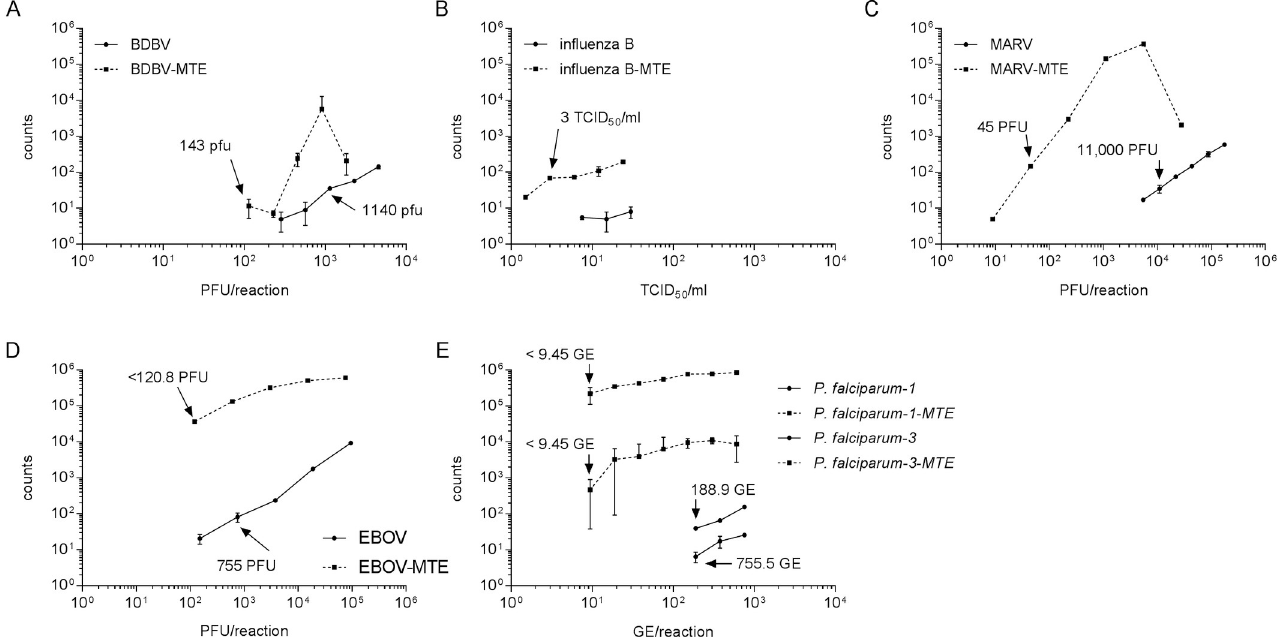
Fig 1. Improved PCR detection following MTE. BDBV (A), influenza B strain 38 (B), MARV (C), EBOV (D), and P . falciparum (E) nucleic acid were serially diluted. One dilution series was amplified by MTE prior to being run in the SYBR Green assay. The amount of pathogen-specific nucleic acid was determined by real-time PCR using primers internal to the MTE amplification primers. Fig B is shown as a dilution factor because influenza B strain 38 did not titer. Samples were run in triplicate, and the error bars represent the standard deviation of the mean. A two-way ANOVA with Bonferroni determined all dilutions for all viruses tested were significantly different with the exception of the highest influenza B virus concentration (~10 3 PFU/rxn).